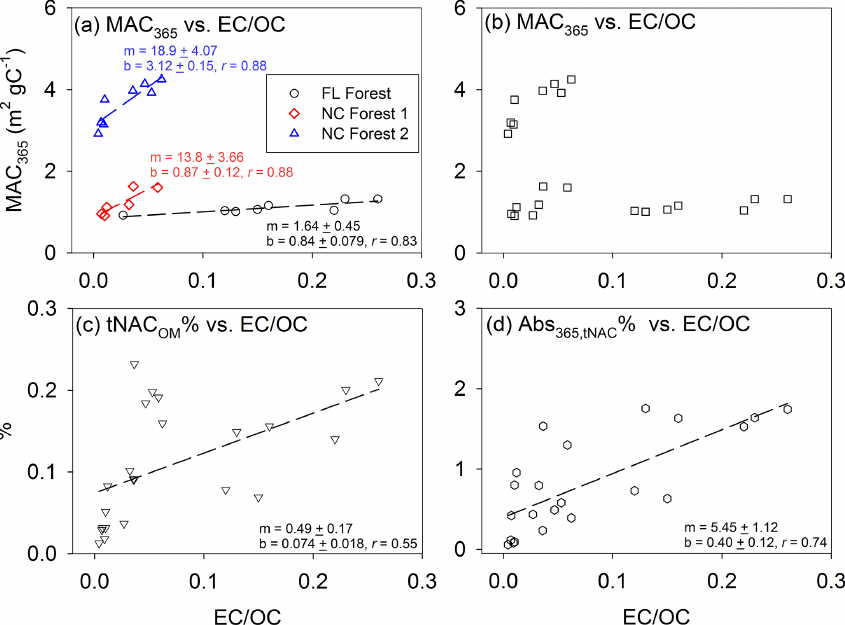
Figure 2. Linear regressions of (a) MAC 365 vs. EC / OC with individual burns data, (b) MAC 365 vs. EC / OC, (c) tNAC OM % vs. EC / OC, and (d) Abs 365 , tNAC % vs. EC / OC with pooled measurements of all the three experiments.